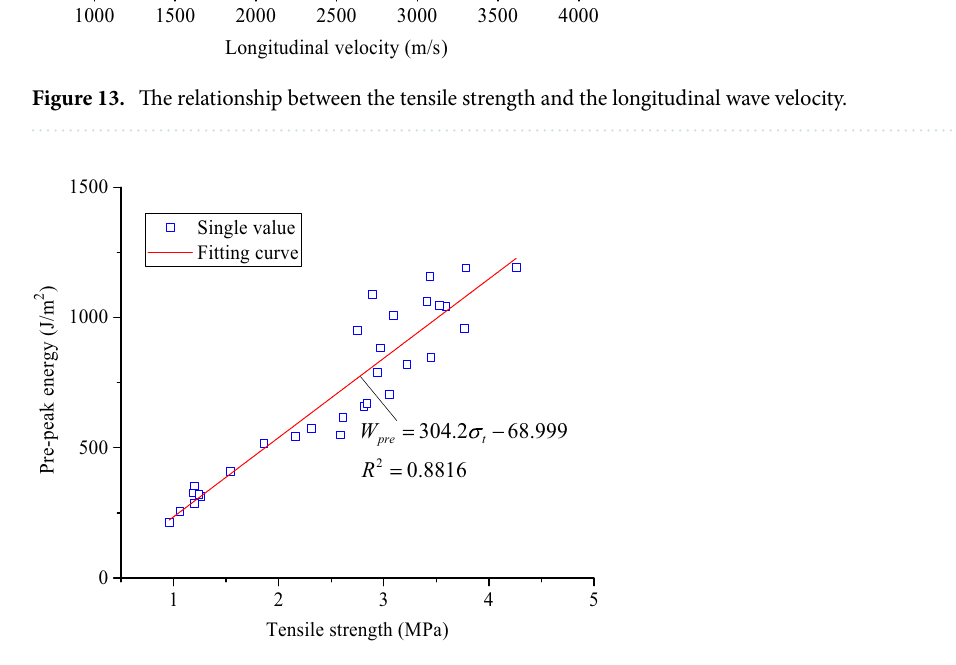
Figure 14. Relationship between prepeak energy and tensile strength of the coarse sandstone